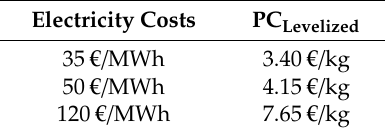
Table 8. Levelized hydrogen production price at di ff erent electric energy